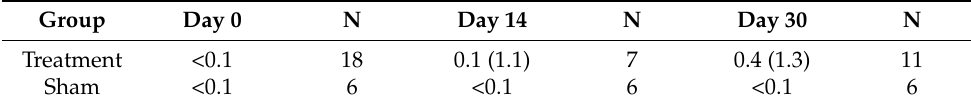
Table 1. Geometric mean (SE) RVNA titer